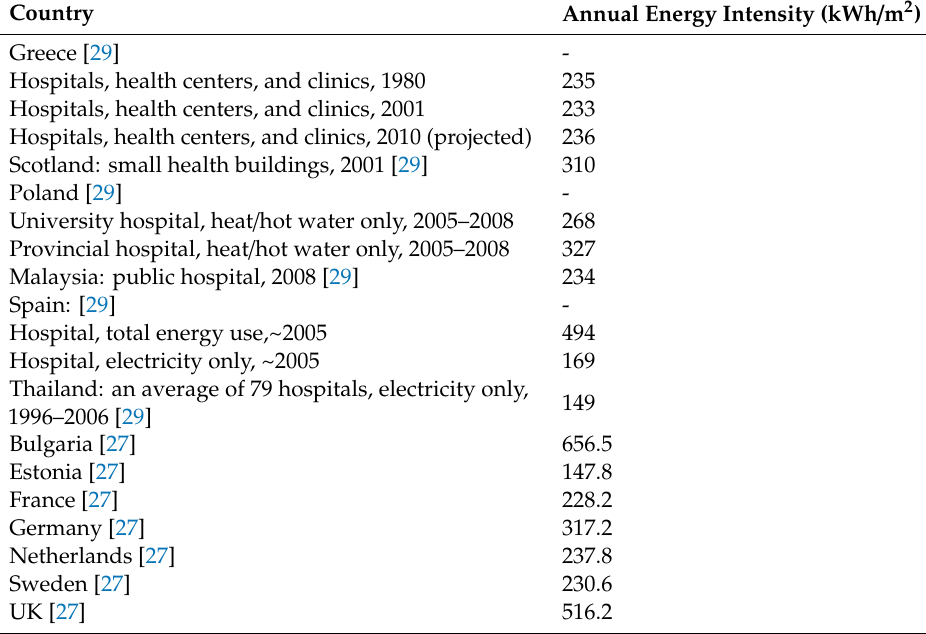
Table 8. Energy intensity of healthcare facilities in other